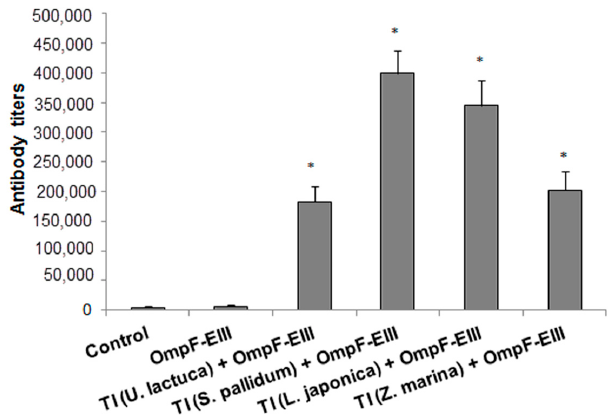
Figure 2. The content of the anti-OmpF-EIII antibodies in mice blood sera depending on the monogalactosyldiacylglycerol (MGDG) in the composition of the TI-complexes. Antibodies were evaluated by ELISA in mice blood sera after two immunizations with individual EIII-OmpF (OmpF-EIII) and OmpF-EIII incorporated in TI-complexes based on the MGDG from Ulva lactuca (TI ( U. lactuca + OmpF-EIII)), Sargassum pallidum (TI ( S. pallidum + OmpF-EIII)), Laminaria japonica (TI ( L. japonica + OmpF-EIII)), or Zostera marina (TI ( Z. marina + OmpF-EIII)), respectively, at a dose of 20 µ g/mouse, administered subcutaneously at an interval of 14 days. The control group included mice immunized with PBS containing 0.125% n -octylglucoside. Each experimental group included ten mice. The experiment was terminated 28 days after the first immunization. Y -axis: The content of anti-OmpF-EIII antibodies in the experimental groups. Data are expressed in titers. Bars represent mean ± SE. * p < 0.05 as compared with the OmpF-EIII.